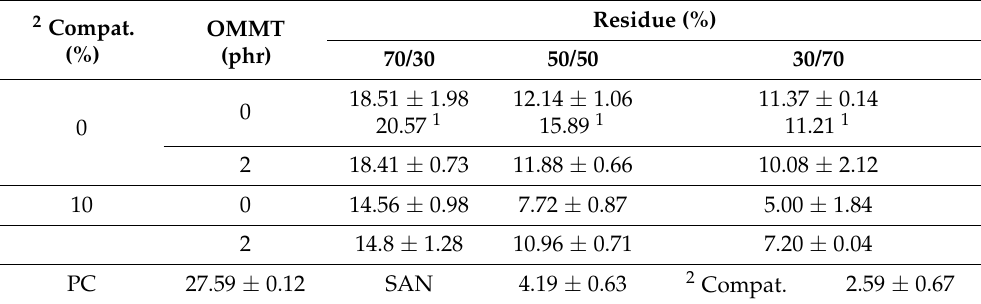
Table 3. Residue of non-compatibilized and compatibilized (with ABS-g-MAH) PC/SAN blends and their